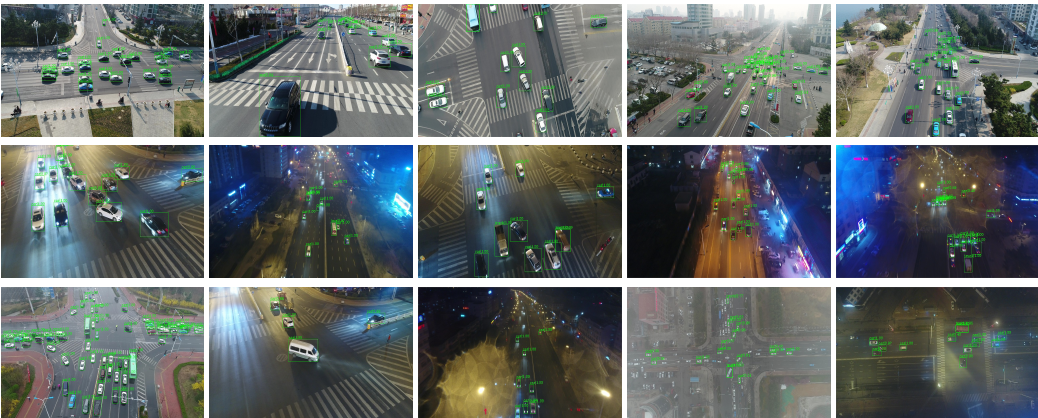
Figure 4. Detection results of the proposed GDF-Net approach on the UAVDT dataset. Detections are labeled with green rectangles and marked with associated categories and confidence